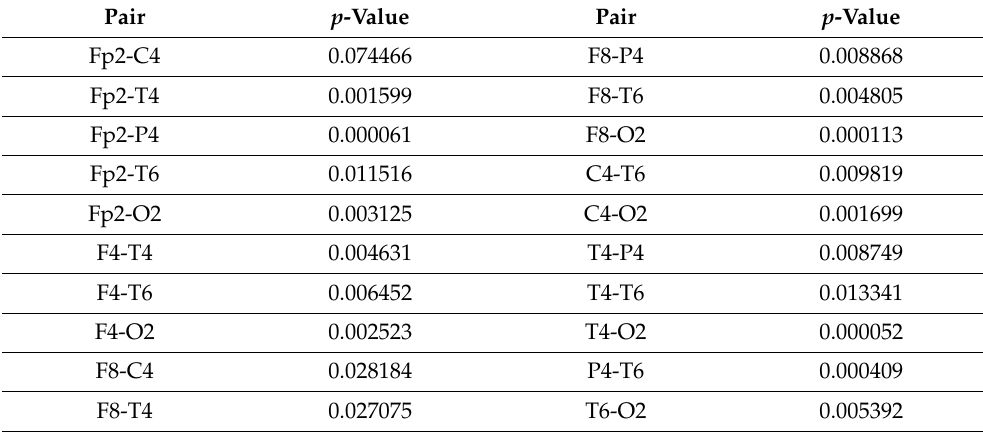
Table 6. The right intrahemispheric coherence value resulted in p < 0.05.